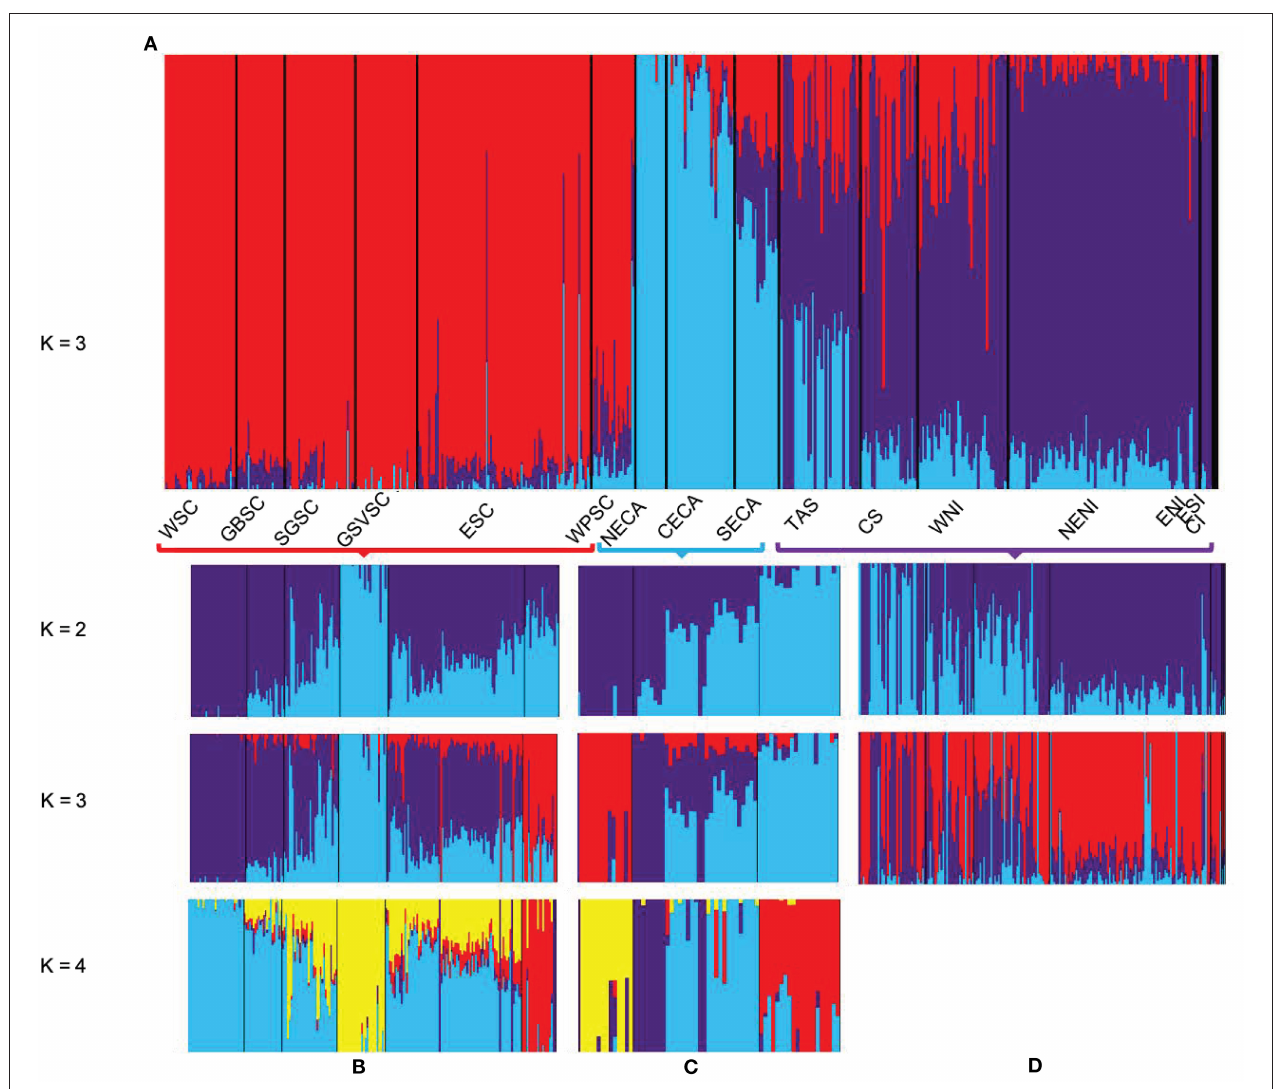
FIGURE 2 | Population genomic structure analysis using Admixture based on 14,799 SNPs for Australasian common dolphins ( Delphinus delphis ) (labeled by locality*). The results depict levels of admixture for each individual sample and grouping into two and/or three genomic clusters. Each sample (labeled by geographic sample groups in the x axis) is represented by one vertical line and is color-coded by the membership probability to (A) one of the three regional populations in Australia and New Zealand or (B–D) one of the potential local populations of the: (B) Southern coast of Australia; (C) Eastern coast of Australia; or (D) New Zealand and Tasmania. *Acronyms used as in Figure 1